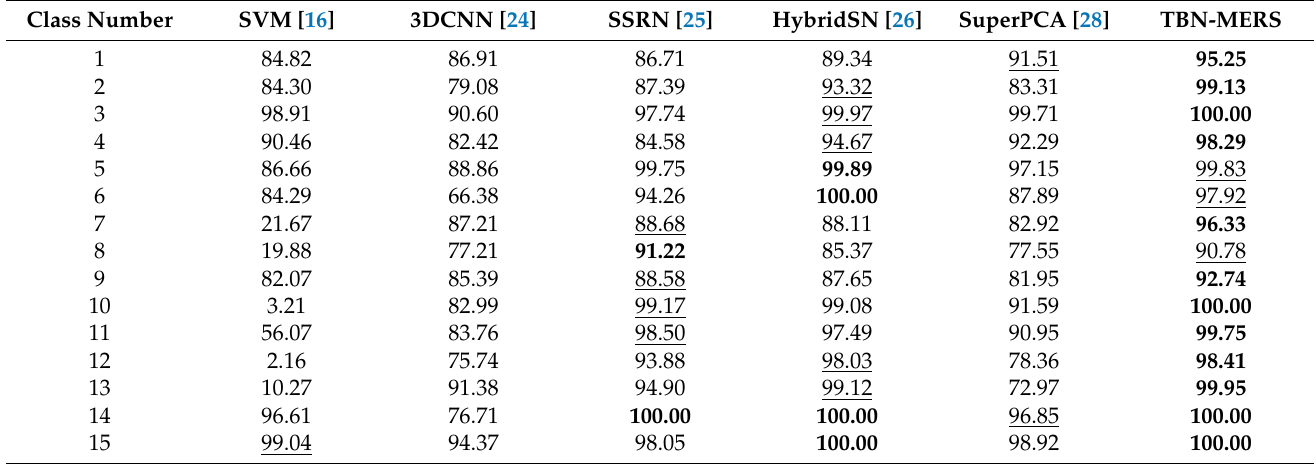
Table 13. Classification results of different methods on HU with 50 samples per